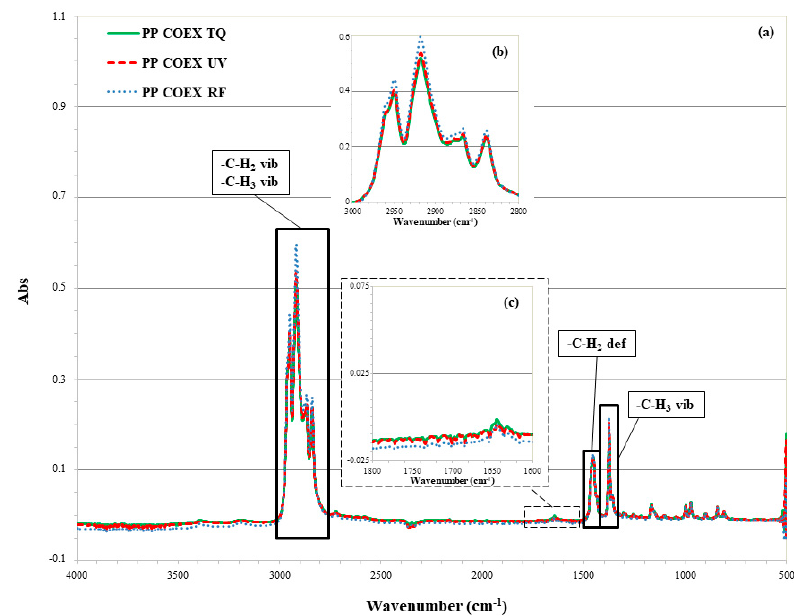
Figure 3. ATR-FTIR spectra of ( a ) PP Coex, before (TQ) and after UV and RF treatments; expansions in the regions ( b ) 3000-2800 cm − 1 and ( c ) 1800-1600 cm − 1 .